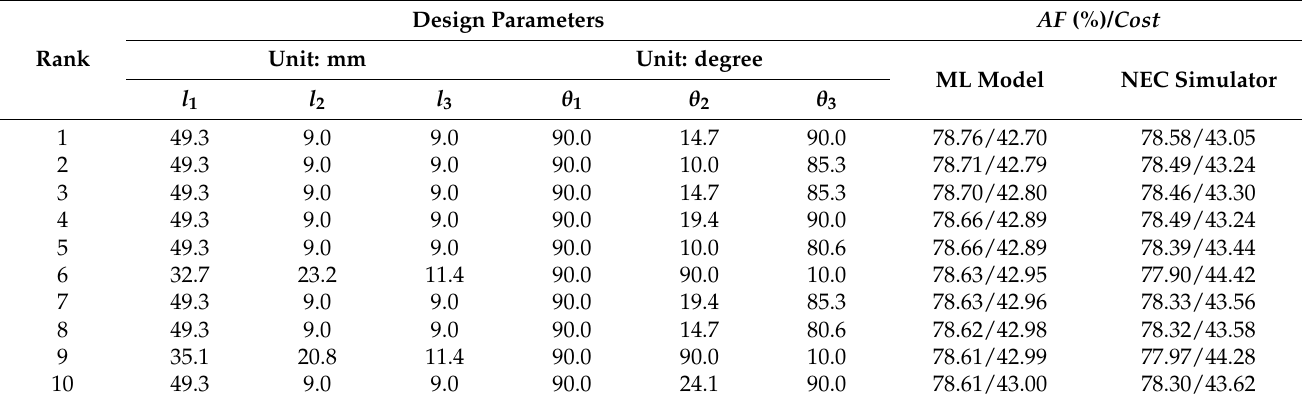
Table 6. Design parameters of the ranked antenna models in terms of AF when searching antenna models on the entire grid.